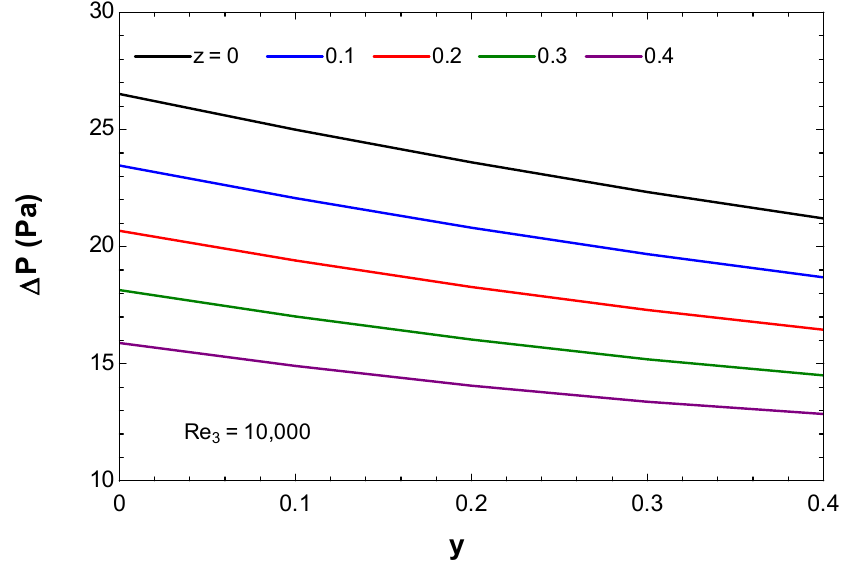
Figure 6. Effect of airflow ratios on pressure difference.